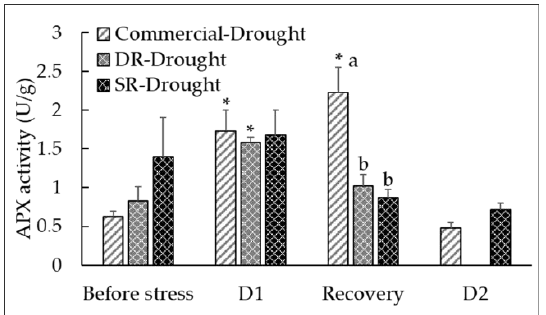
Figure 6. Changes in APX enzyme activity in Cabernet clones under two recurrent drought cycles. Values are means ± SEM of six biological replicates. Statistical analysis was conducted using two-way ANOVA. Asterisks indicate statistically significant differences ( p < 0.05) of drought treated clones relative to before stress. Lowercase letters indicate statistically significant differences ( p < 0.05) between drought treated clones within each treatment.